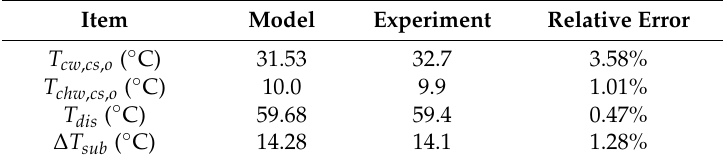
Table 3. Model Validation of hybrid system.